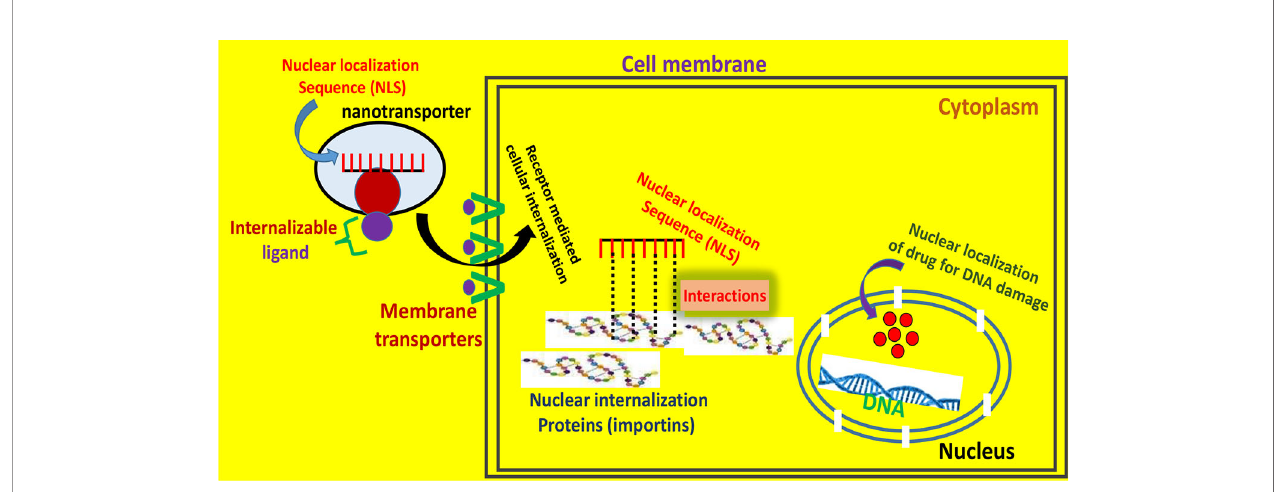
FIGURE 4 | Membrane and subcellular traf fi cking implicated in the nuclear localization mechanism of drugs. The nanotransporter comprises an internalizable ligand which facilitates the receptor mediated cell entry, and a nuclear targeting moiety (nuclear localization sequence; NLS) which enters the nuclear region and regulates the gene expression.